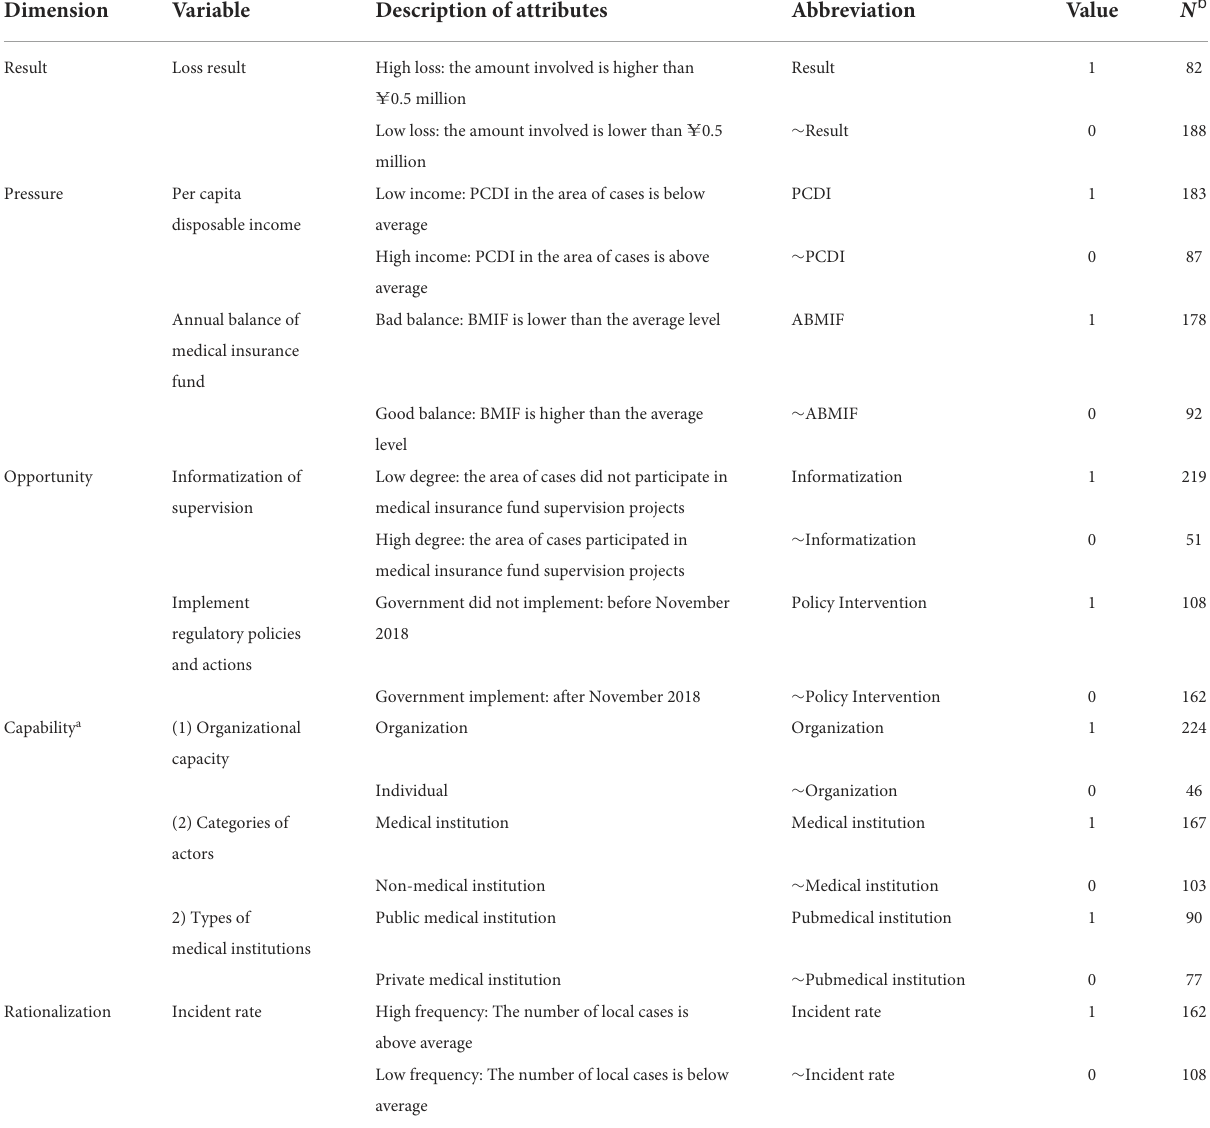
TABLE 2 Assignment rules for variables in cs QCA. Dimension Variable Description of